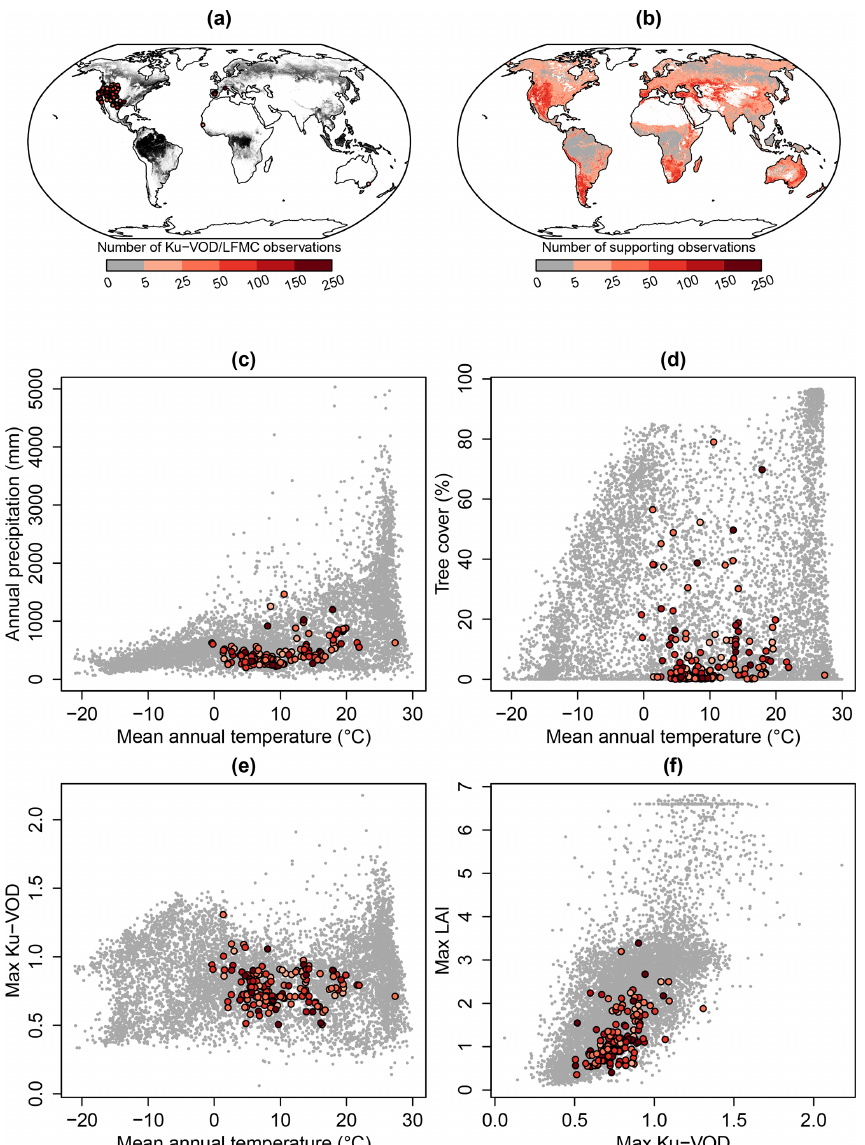
Figure A4. Distribution of the number of joint observations of Ku-VOD and Globe-LFMC measurements. (a) Distribution of Globe-LFMC sites overlaid over the percentage tree cover. (b) Spatial estimate of the number of supporting observations that indicates how many pairs of Ku-VOD/Globe-LFMC observations are available with similar mean annual temperature and vegetation conditions (i.e. LAI, tree cover, Ku-VOD). To create this map, a random forest regression was fitted to the number of observations shown in (a) and by using mean annual temperature, tree cover, mean annual maximum Ku-VOD, and mean annual maximum LAI as predictors. The fitted random forest model was then applied to each 0.25 ◦ grid cell to provide an estimate of how many observations are actually supporting an LFMC estimate in a grid cell. (c, d) Number of observation within the global feature space of mean annual temperature and annual total precipitation (c) and mean annual temperature and tree cover (d)